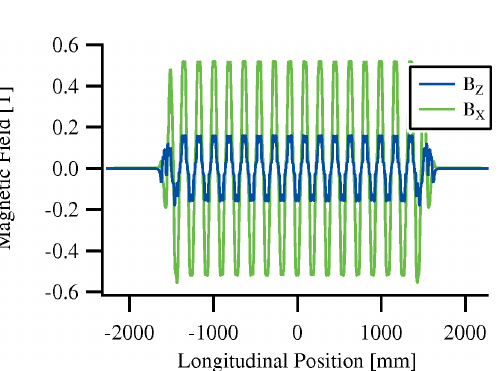
Figure 2 Magnetic field profile in EPU 180 mm, modelled as a periodic device, calculated at gap = 15 mm, (cid:4) E = 0 mm and (cid:4) L = (cid:2) 60